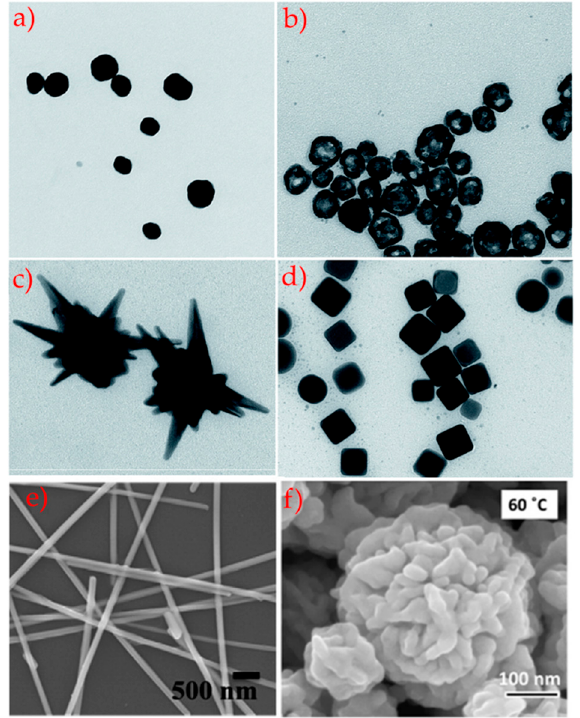
Figure 4. TEM images of AgNPs TEM micrographs presenting AgNPs with di ff erent geometry and shapes: ( a ) spherical silver nanoparticles, ( b ) hollow spherical silver nanoparticles, ( c ) nanostars, ( d ) cubic silver nanoparticles, adapted from [97]; ( e ) silver nanorods adapted from [98] and ( f ) silver nanoflower adapted from